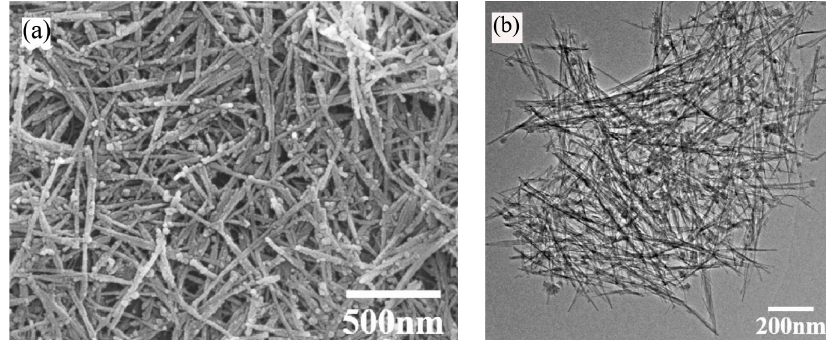
Figure 8. ( a ) SEM image and ( b ) TEM image of the cetyltrimethylammonium bromide (CTAB)-derived MnO 2 nanowires [81].